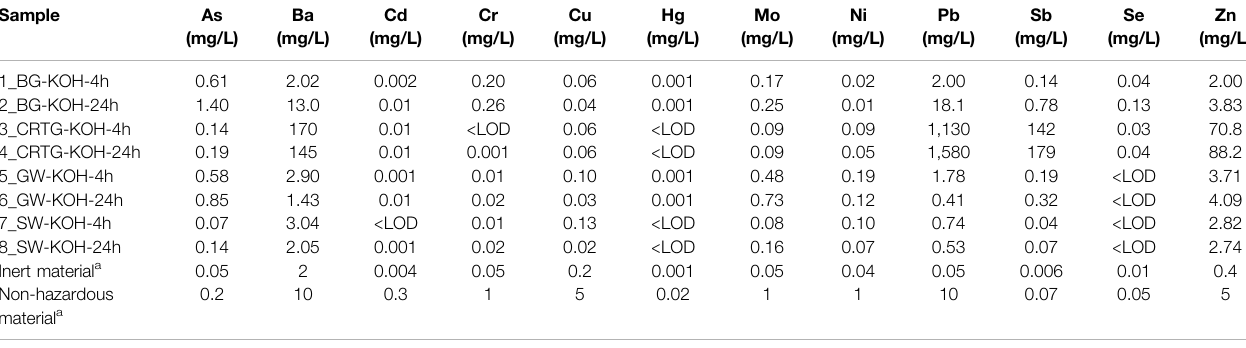
TABLE 5 | Concentrations of toxic trace and minor elements in AAAs prepared AAAs with a m precursor /m KOH ratio of 0.1 g/ml. Sample